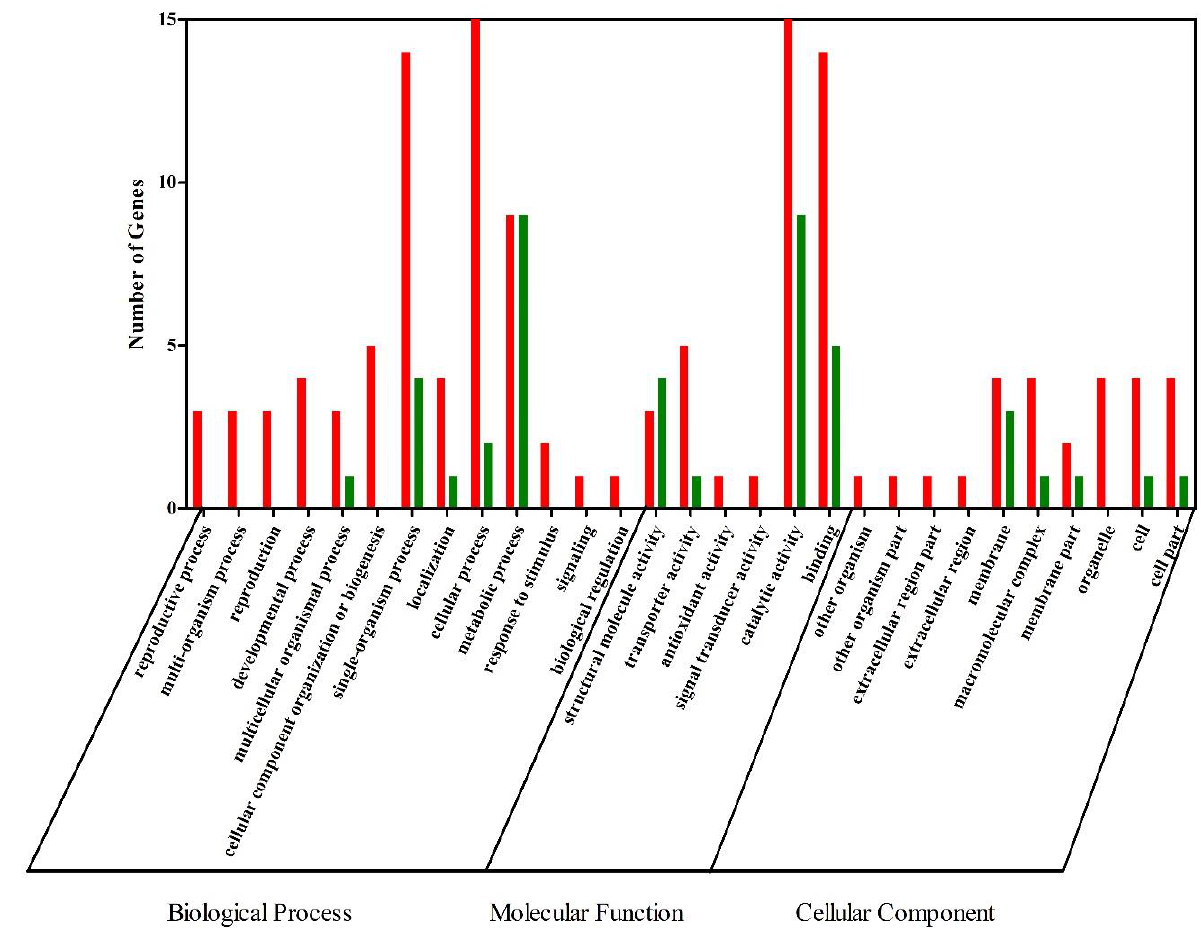
Figure 2. GO annotation of DEGs. DEGs with a GO annotation were divided into three major categories: biological process, cellular component, and molecular function. Red columns represented the DEGs with higher expression levels in the EcR group, while green columns represented the DEGs with lower expression levels in the EcR group.